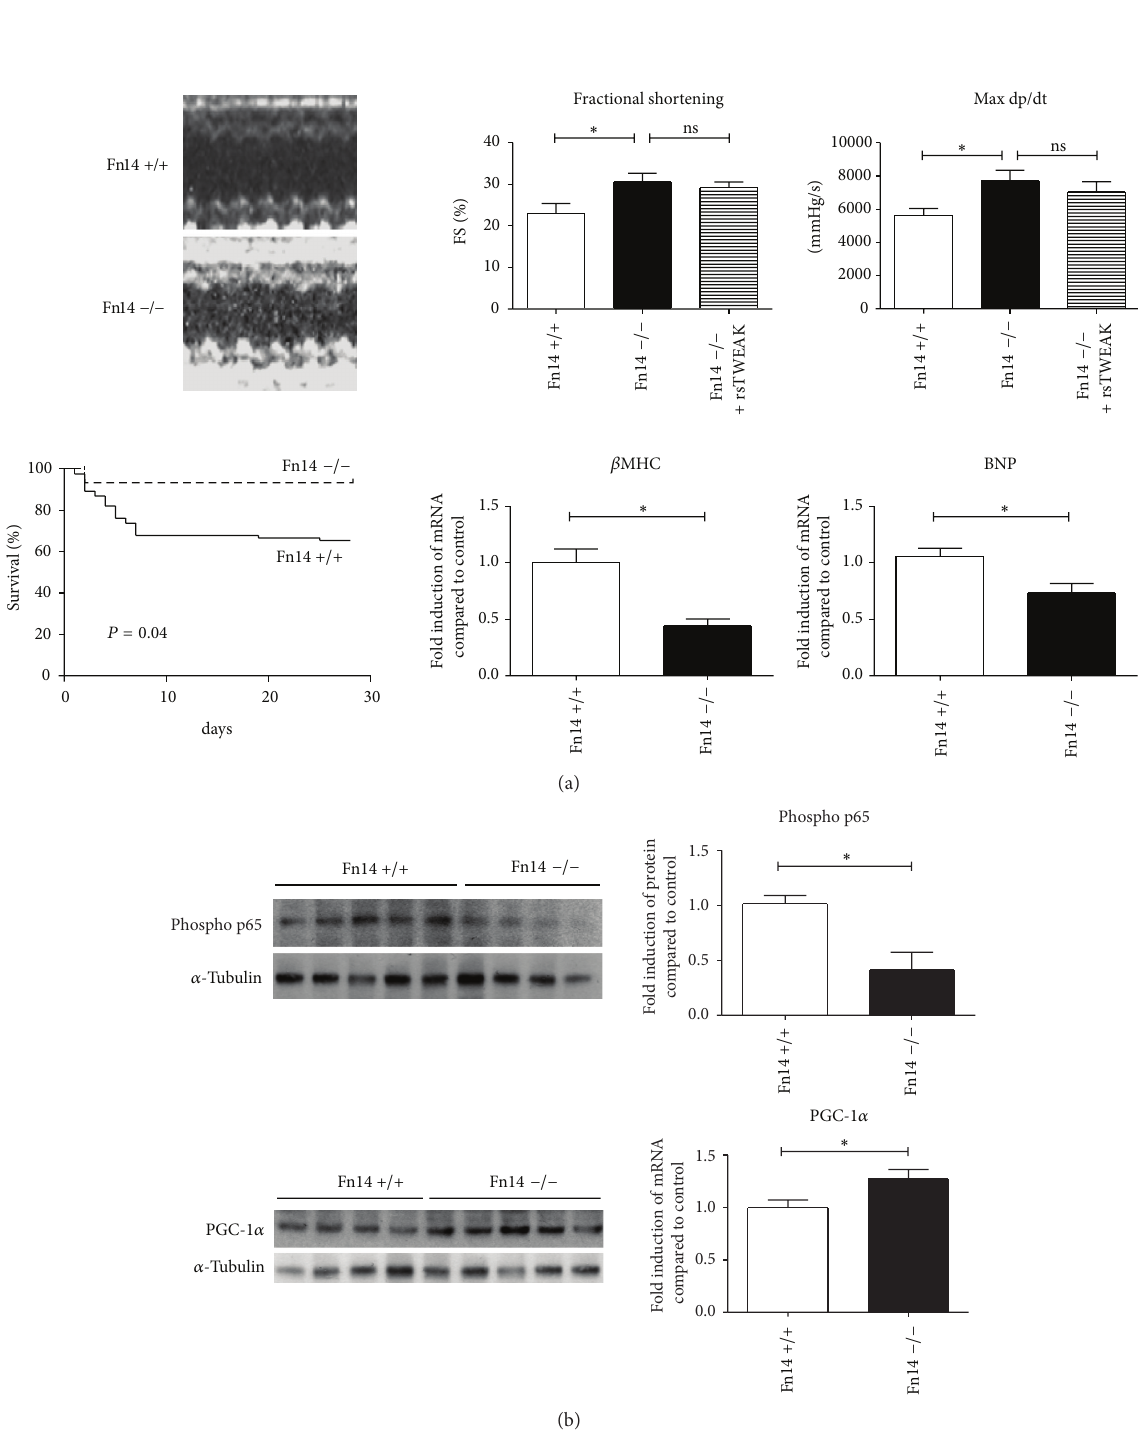
Figure 5: Genetic ablation of the Fn14 improves ventricular dysfunction and survival. (a) Genetic ablation of Fn14 in Fn14 −/− mice protected from progressive deterioration of left ventricular function after MI. Overall this resulted in improved survival after MI ( 𝑃 = 0.04 ; 𝑛 = 15 for each group for survival analysis). (b) Fn14 −/− mice also demonstrated reduced phosphorylation of p65. In addition upregulation of PGC-1 𝛼 compared to wildtype littermates (Fn14 +/+) was also observed ( 𝑛 = 5 for Fn14 +/+ and 𝑛 = 6 for Fn14 −/− for molecular